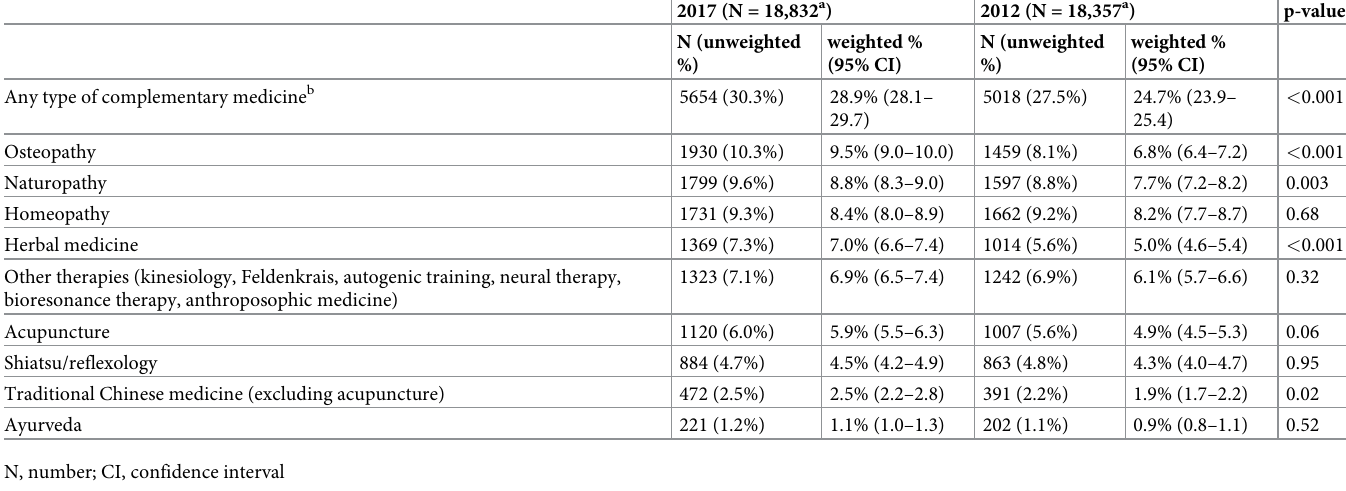
Table 1. Prevalence of complementary medicine use in the past 12 months according to the self-completed questionnaire from the Swiss Health Survey 2012 and 2017.